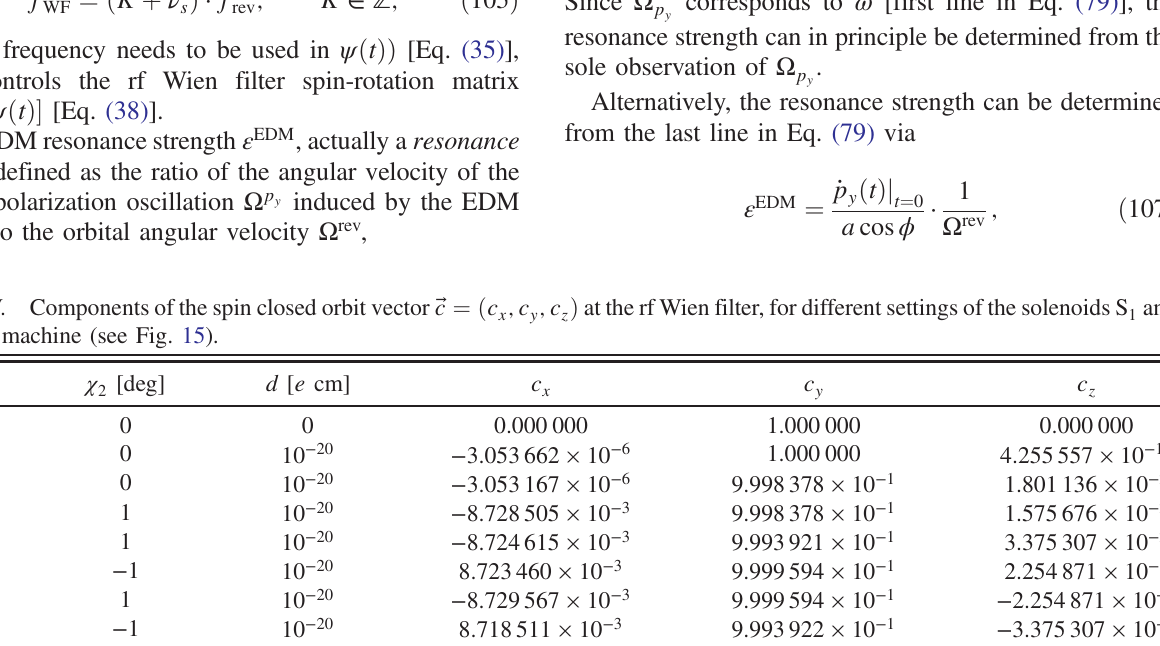
FIG. 17. Six panels showing the components of ⃗ c ¼ ð c two solenoids in the ring (see Fig. 15), for deuterons at a momentum of P ¼ 970 MeV =c .